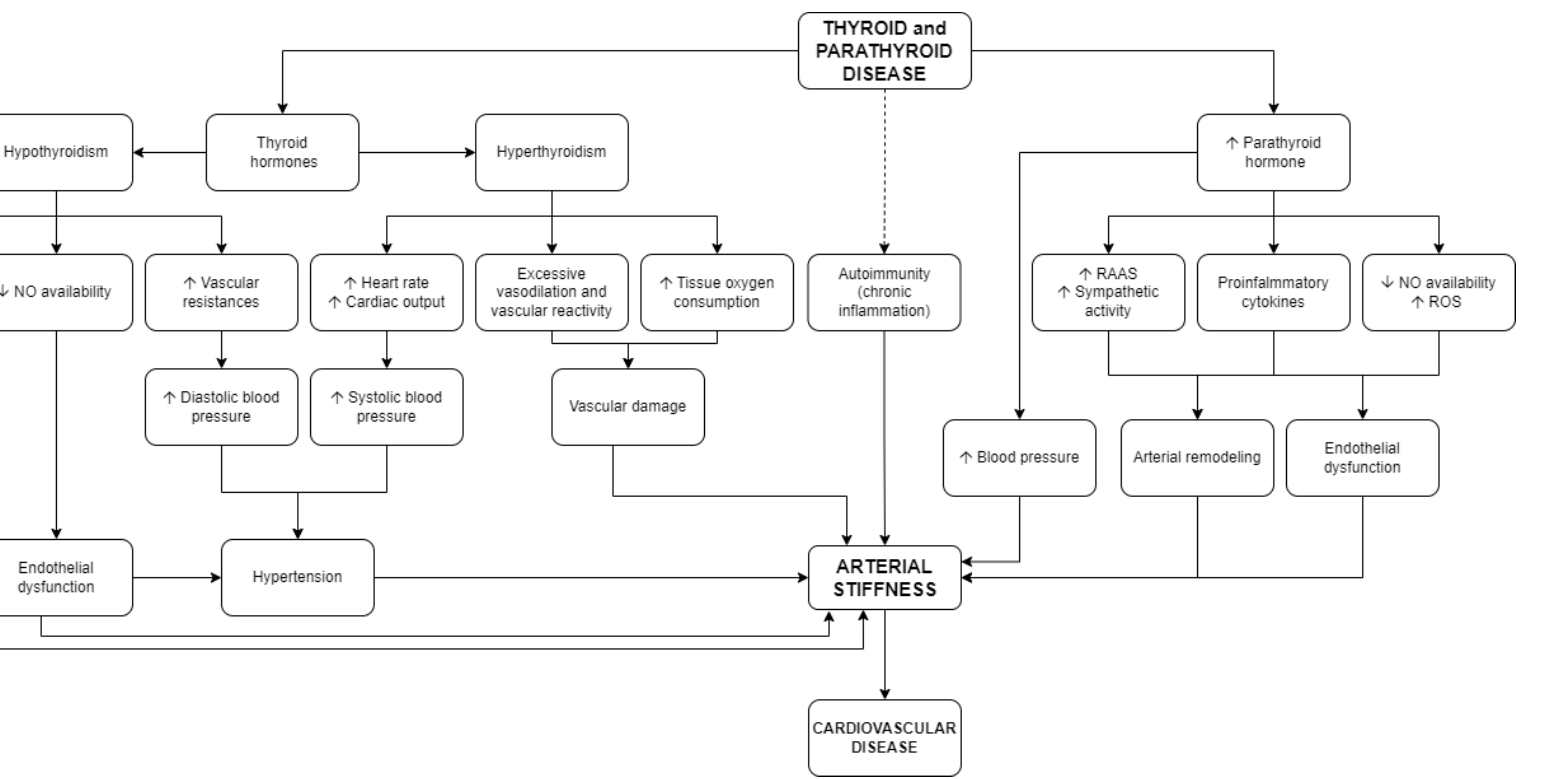
Figure 1. Pathophysiology of arterial stiffness in thyroid and parathyroid disease. RAAS: renin-angiotensin-aldosterone system. NO: nitric oxide. ROS: reactive oxygen species.